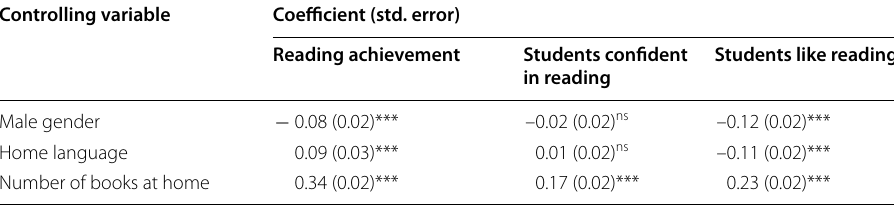
***p < 0.001; **p < 0.01; *p < 0.05; + p < 0.10; ns p